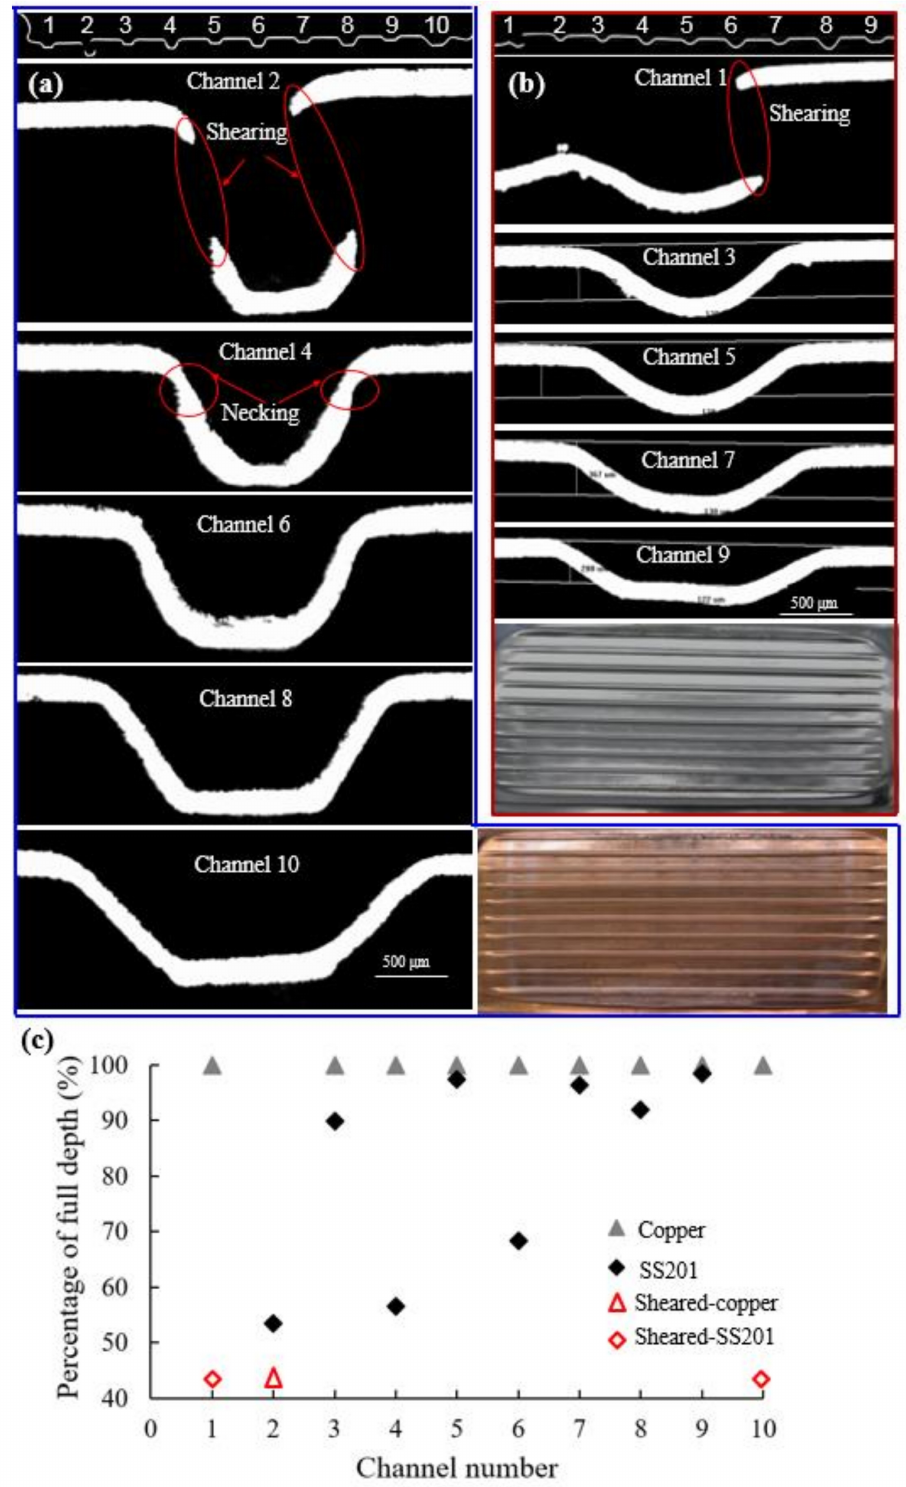
Figure 11. Photo and optical microscope images of ( a ) a deformed copper plate and ( b ) a deformed SS201 plate and ( c ) the percentage of full depth for deformed Cu110 and SS201 metal